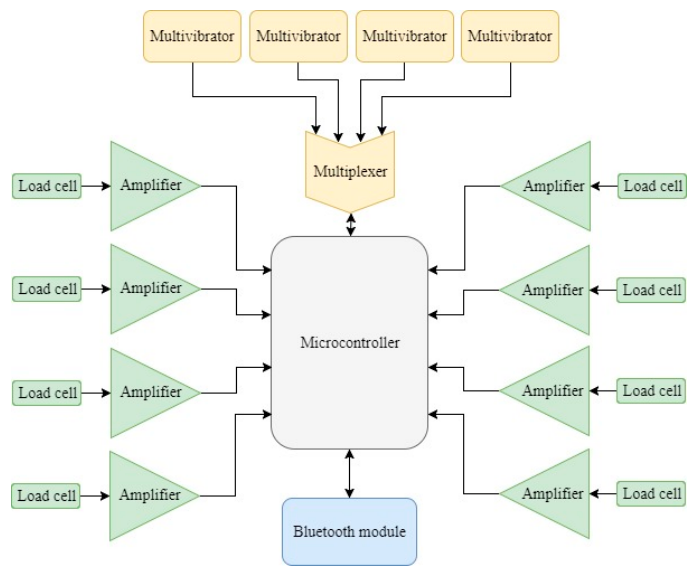
Figure 10. System overview.